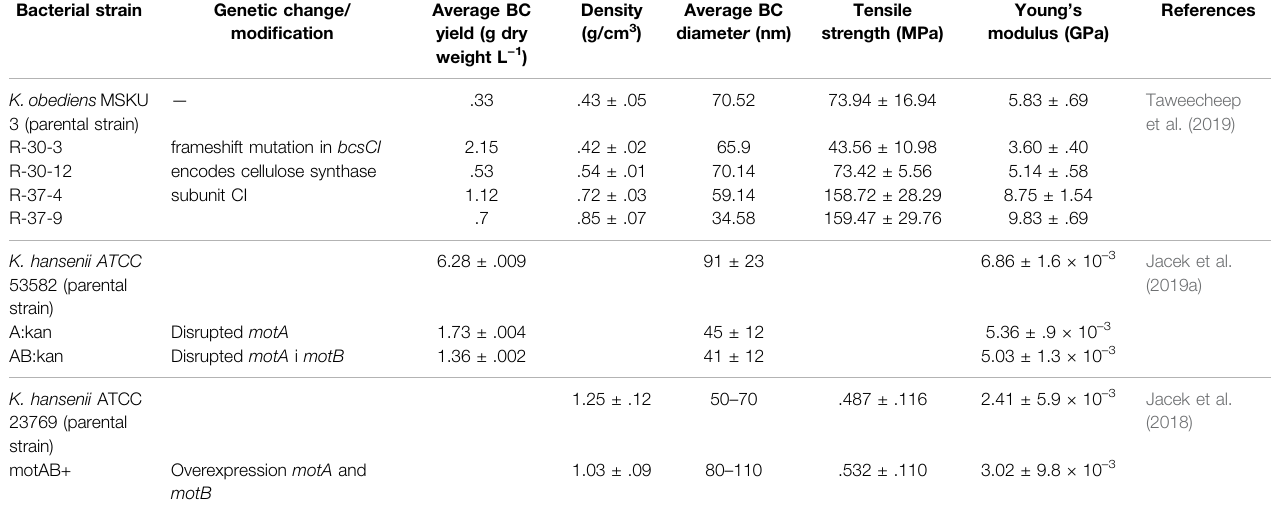
TABLE 4 | Characteristics of BC produced by Komagataeibacter mutants. Bacterial strain Genetic change/ modi fi